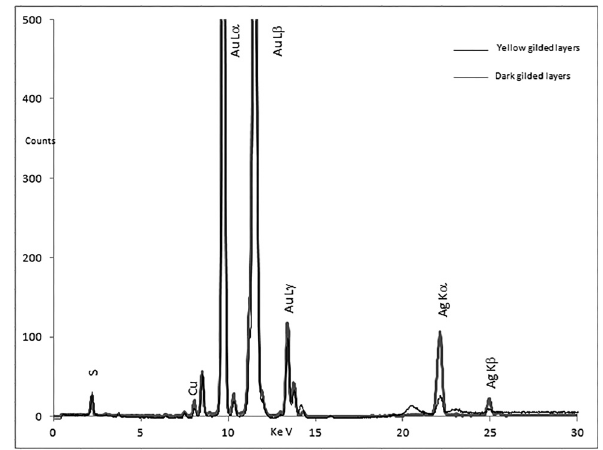
Figure 8: Comparing the obtained XRF spectra for yellow and dark areas